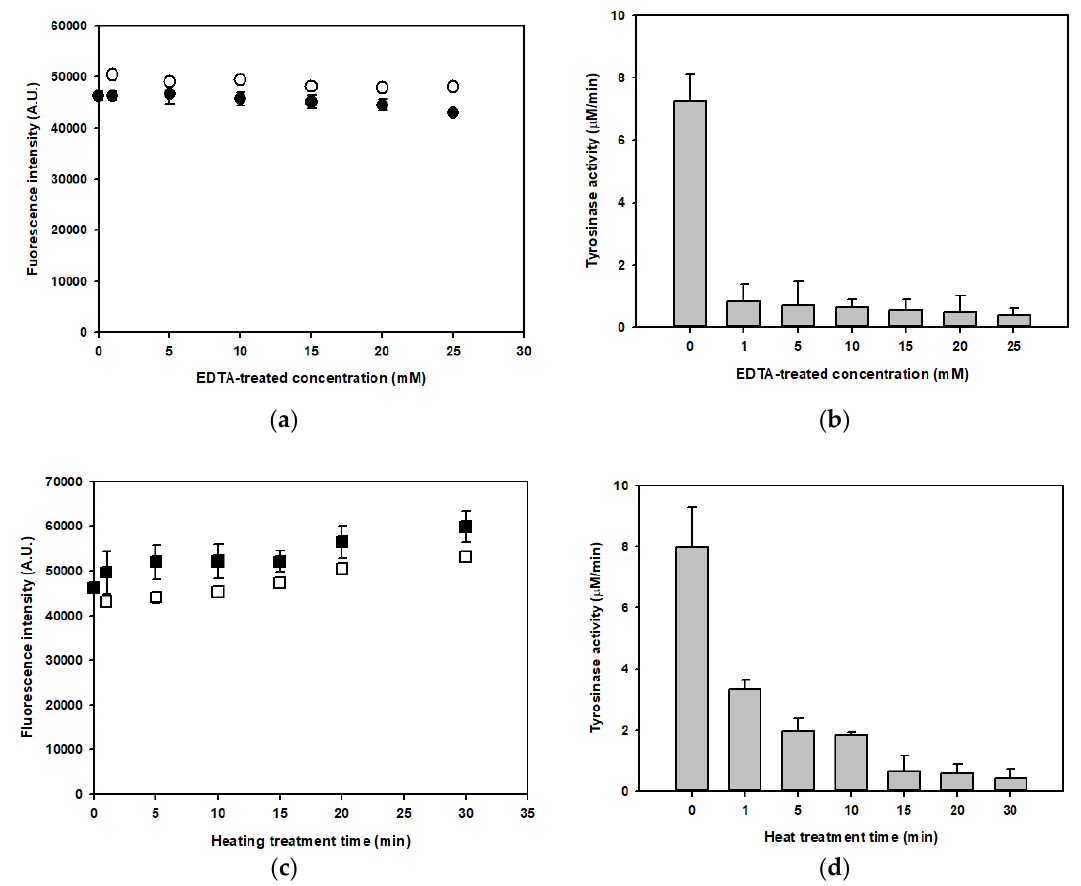
Figure 4. Measurement of fluorescence intensities and tyrosinase activities in the mushroom lysate treated with EDTA or heat. ( a ) Fluorescence intensities of the EDTA-treated lysates at the initial time (black circles) and 14 days later (white circles). ( b ) Total tyrosinase activities of EDTA-treated lysates. ( c ) Fluorescence intensities of the heat-treated lysates at the initial time (black squares) and 14 days later (white squares). ( d ) Total enzyme activities of the heat-treated lysates. Fluorescence intensities (Arbitrary Unit, A.U.) and tyrosinase activities of all fractions were measured under the optimum conditions with λ E × 380 nm~ λ Em 460 nm and the enzyme assay conditions described, respectively.